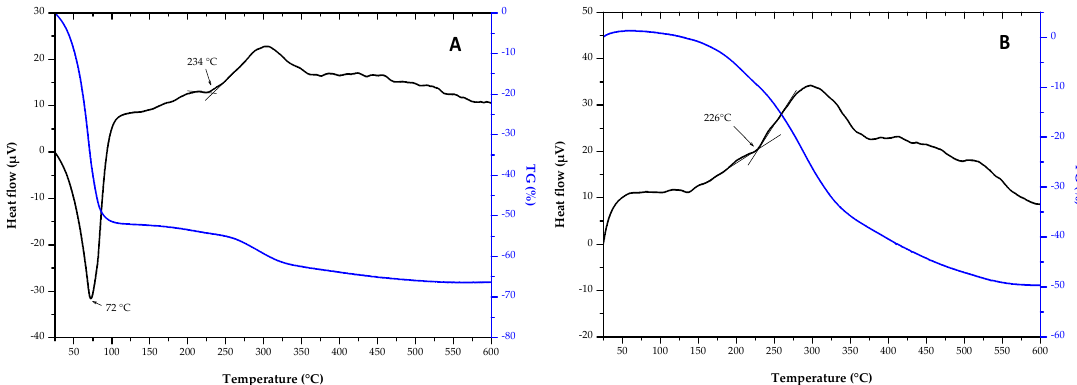
Figure 4. Thermogravimetric-differential (TG-DTA) curves for ( A ) GZA sol and ( B ) GZA xerogel. TG-DTA curve for sol GZA showed endothermic peak until 72 ◦ C with loss mass of 52%.